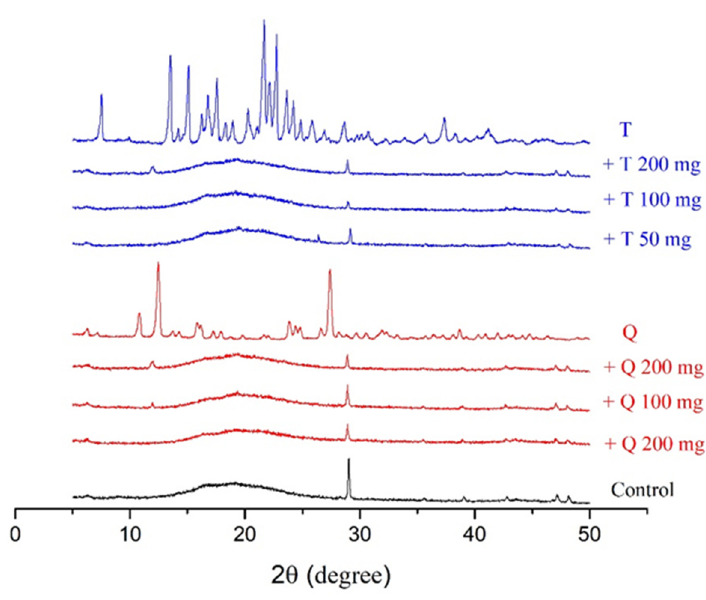
Figure 4. XRD peaks of cassava starch/gelatin films with quercetin (Q) and TBHQ (T).